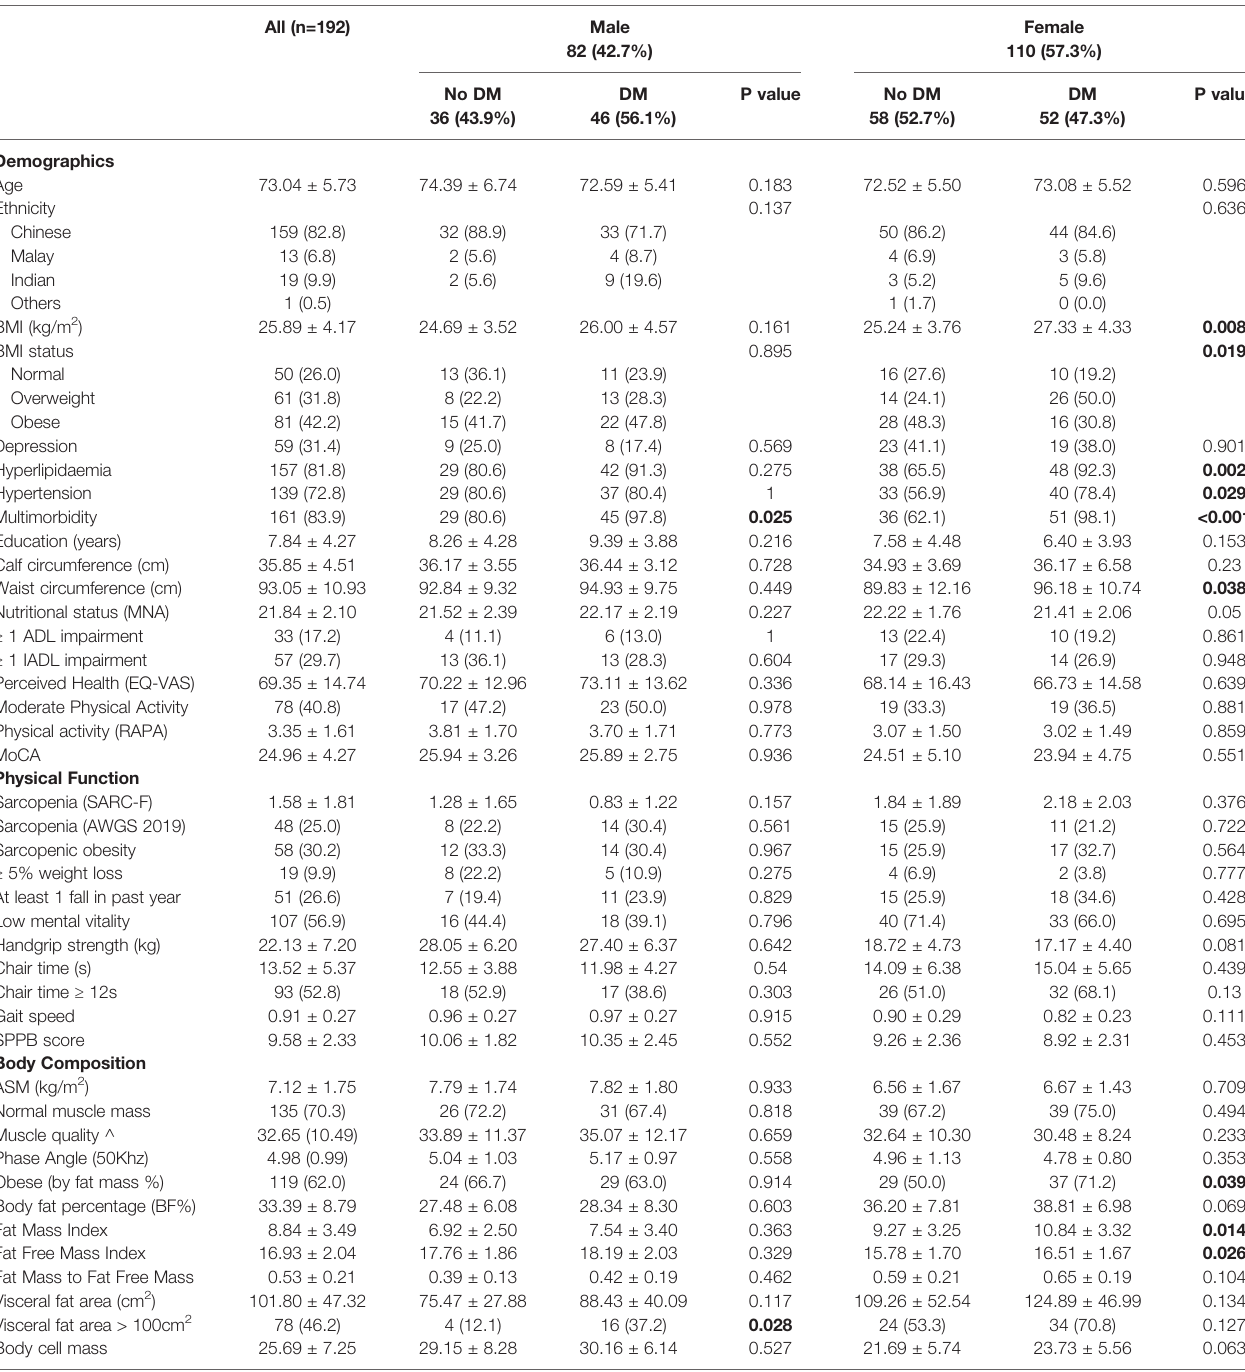
TABLE 1 | Characteristics table displaying within gender differences by Diabetes Mellitus (DM) Status. All (n=192) Male